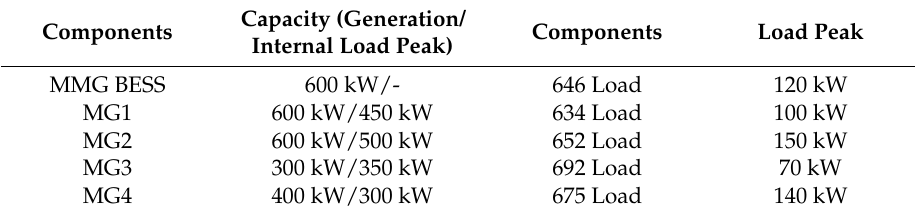
Table 1. Parameters of the MMG elements.